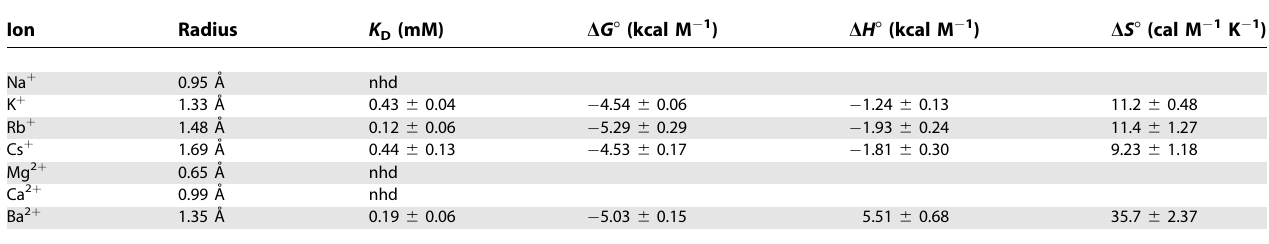
Each value represents the results from three or more independent ITC experiments. K D and D H 8 were obtained from a fit to a single binding isotherm [8], whereas D G 8 and D S 8 were calculated from D G 8 ¼ RT ln K D and D G 8 ¼ D H 8 (cid:2) T D S 8 . The ionic radii were obtained from